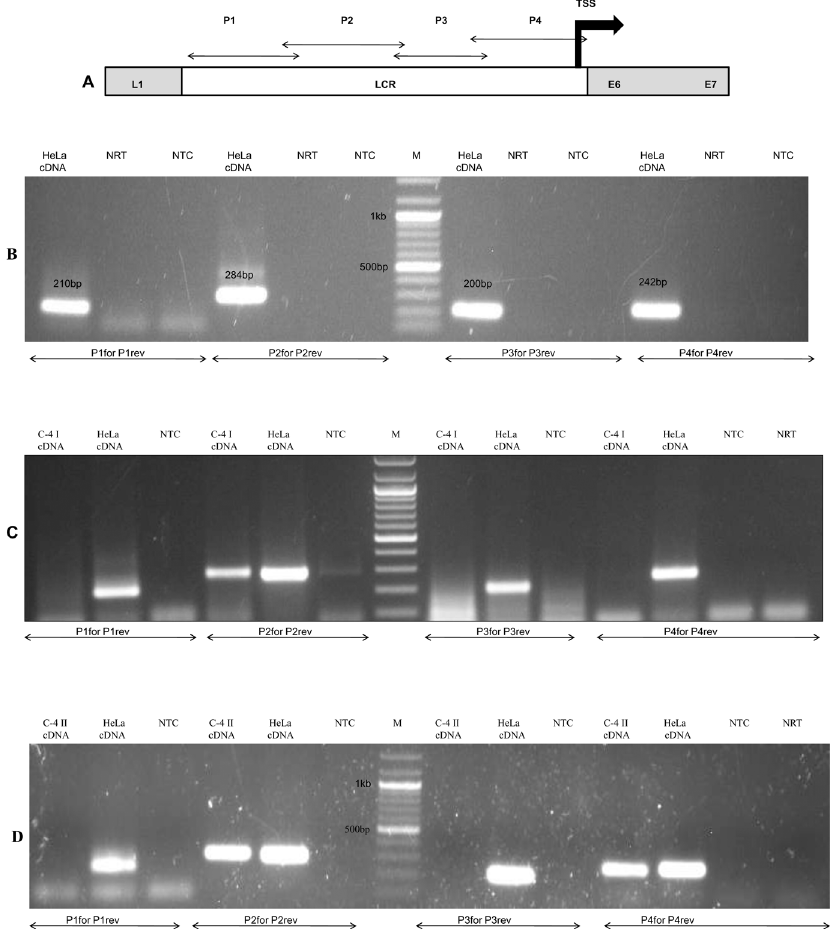
Fig 1. Detection of pRNA at the LCR of HPV18 positive cell lines. (A) Schematic representation of HPV18 LCR showing the position of four LCR specific primers. The flanking genes and the transcription start site (TSS) are also depicted. For the detection of pRNA across LCR, RNA was isolated from HeLa, C-4I and C4-II cells and subjected to RT-PCR using four sets of LCR specific overlapping primers P1, P2, P3 and P4. (B) Gel picture showing pRNA distribution across HeLa LCR. pRNA found at all the regions of LCR (C) pRNA presense at C-4 I LCR. pRNA was detected at P2 region only. (D) pRNA presense at C-4 II LCR. pRNA was detected at P2 and P4 regions of LCR. P1for P1rev: PCR performed with P1F and P1R primers, P2for P2rev: PCR performed with P2F and P2R primers, P3for P3rev: PCR performed with P3F and P3R primers, P4for P4rev: PCR performed with P4F and P4R primers. HeLa cDNA: HeLa cDNA used as positive PCR Control, NRT:negative RT, NTC: no template Control, M: 100bp ladder.